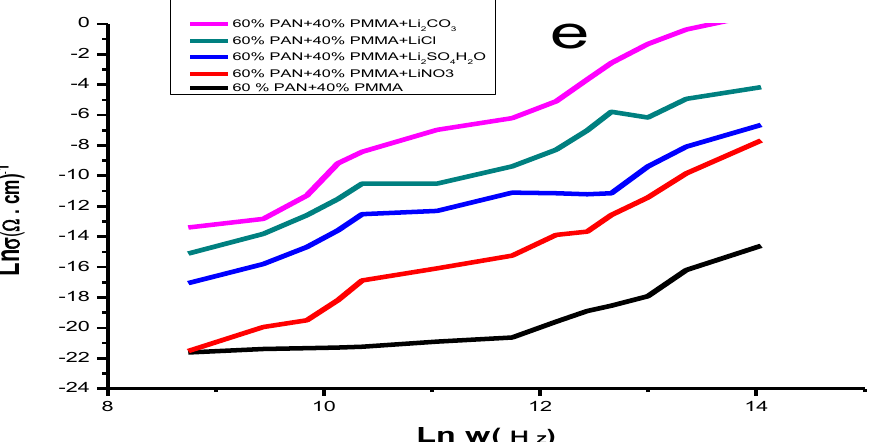
Figure 1 e : Variation of Ln σ